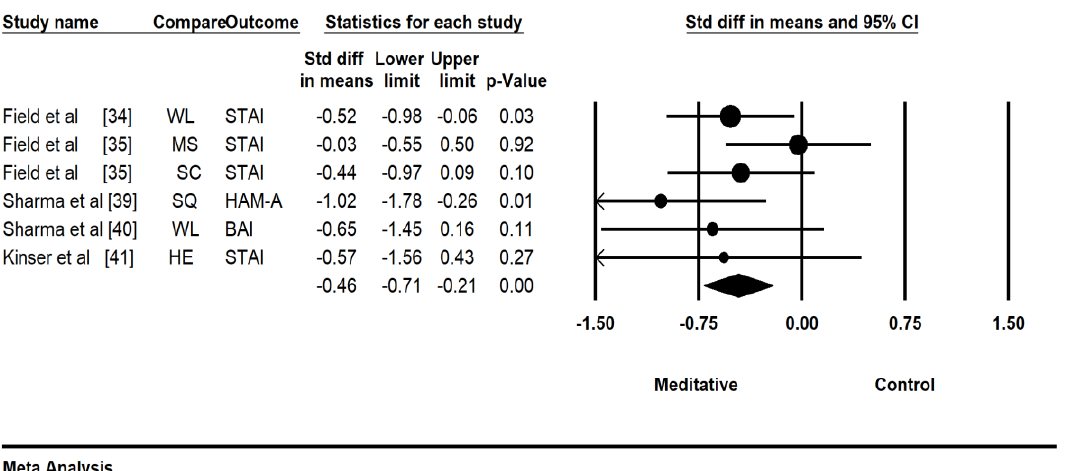
Figure 4. Effects of meditative movements on anxiety.